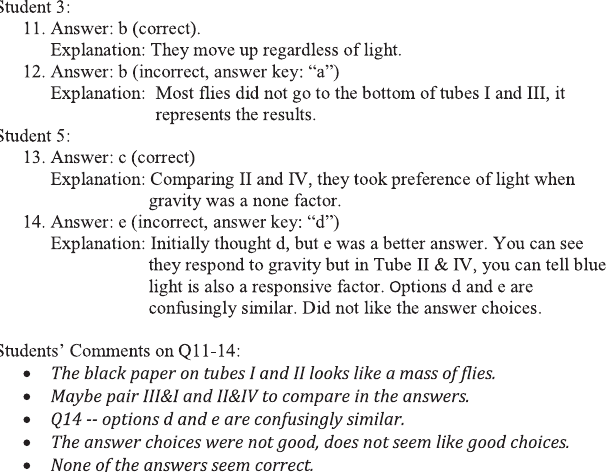
FIG. 7. Examples of students ’ written explanations to